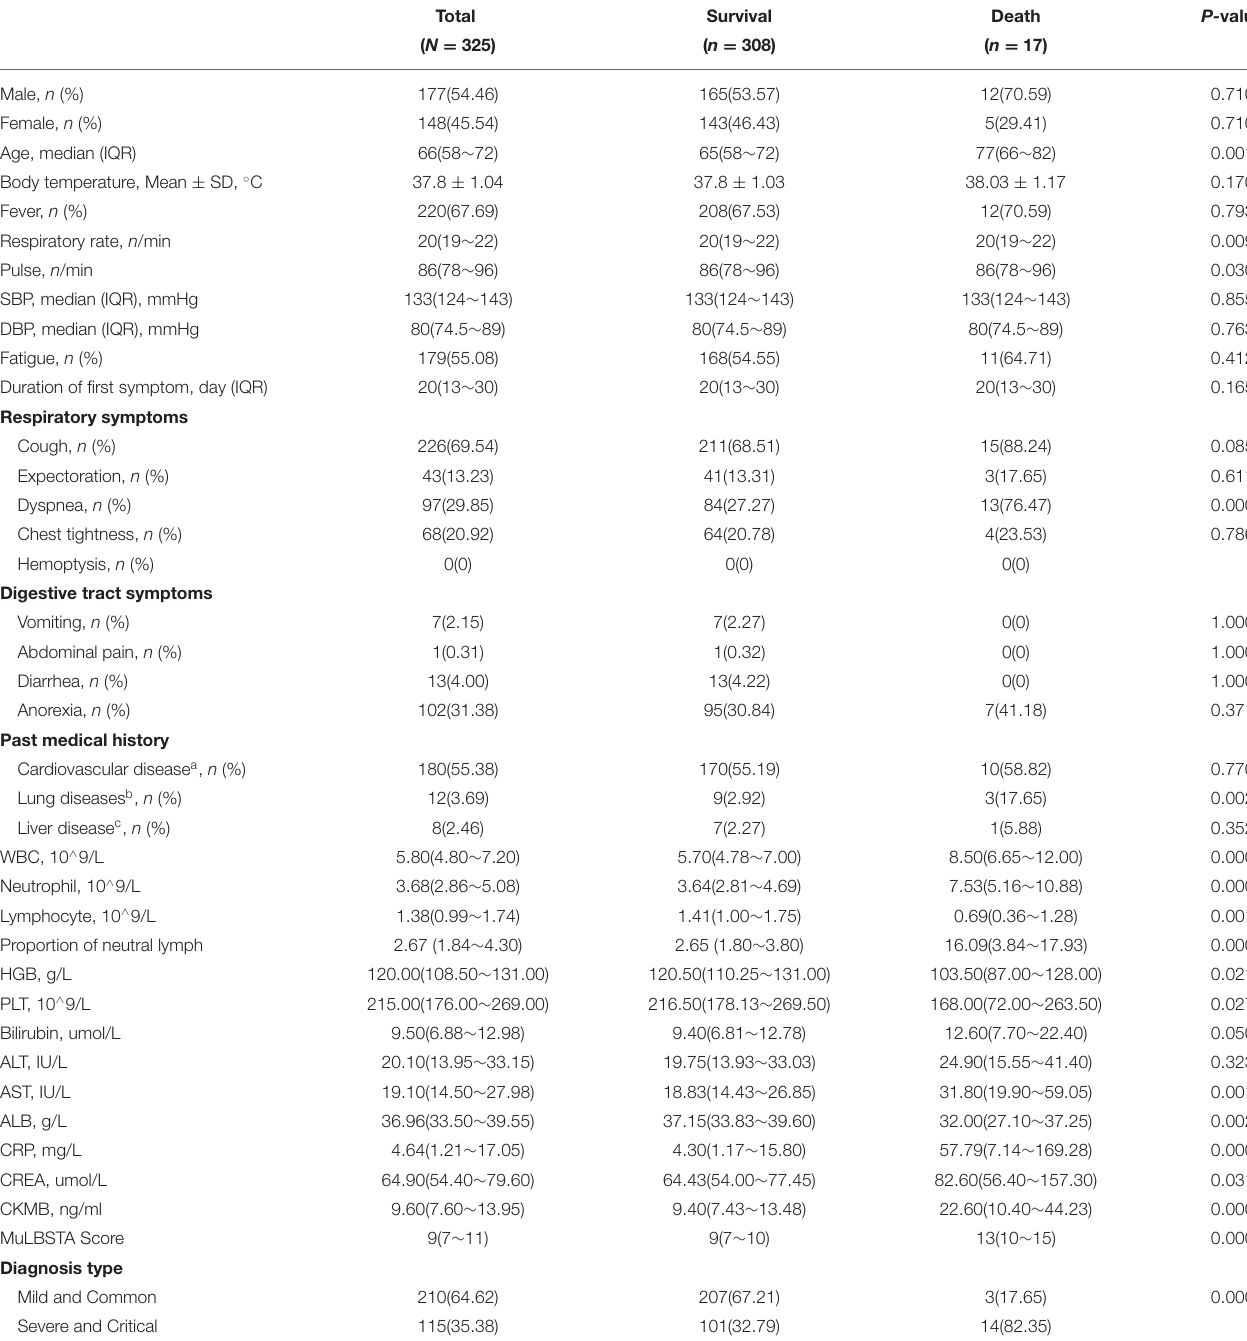
TABLE 3 | Univariate analysis of death-related factors in diabetic patients with COVID-19 ( N = 325). Total Survival Death P-